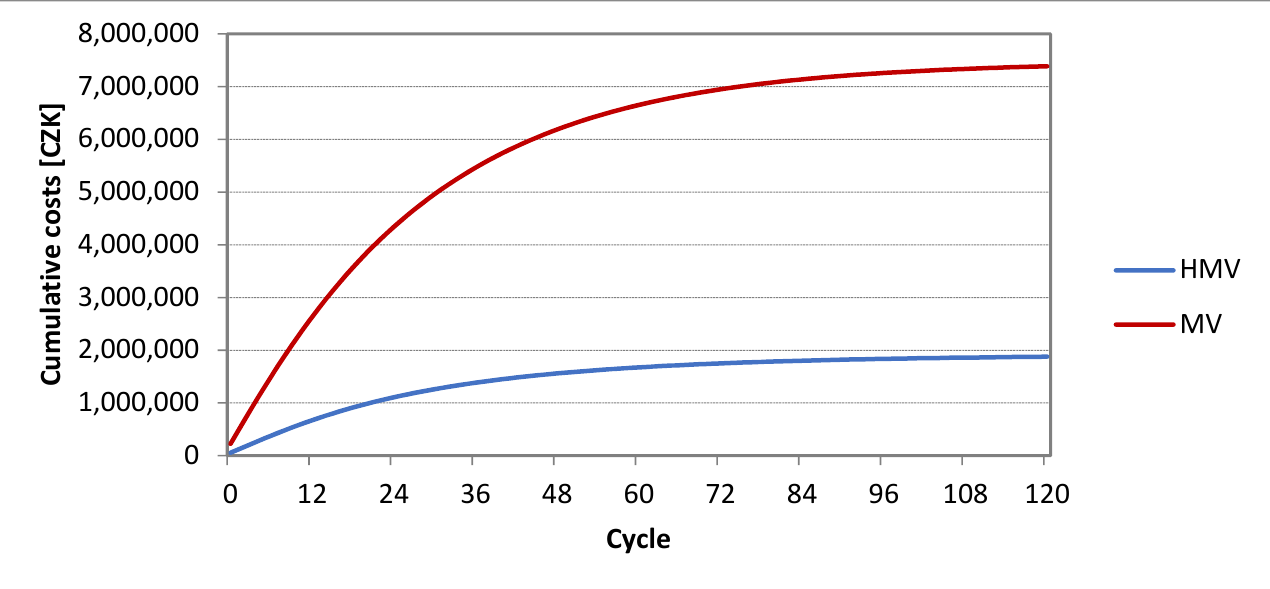
Figure 4. Cumulative costs.